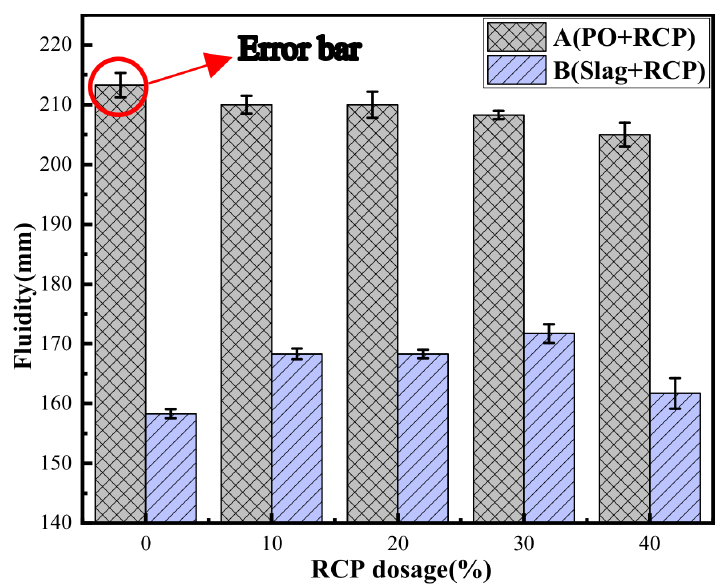
Figure 7. Influence of the RCP content on